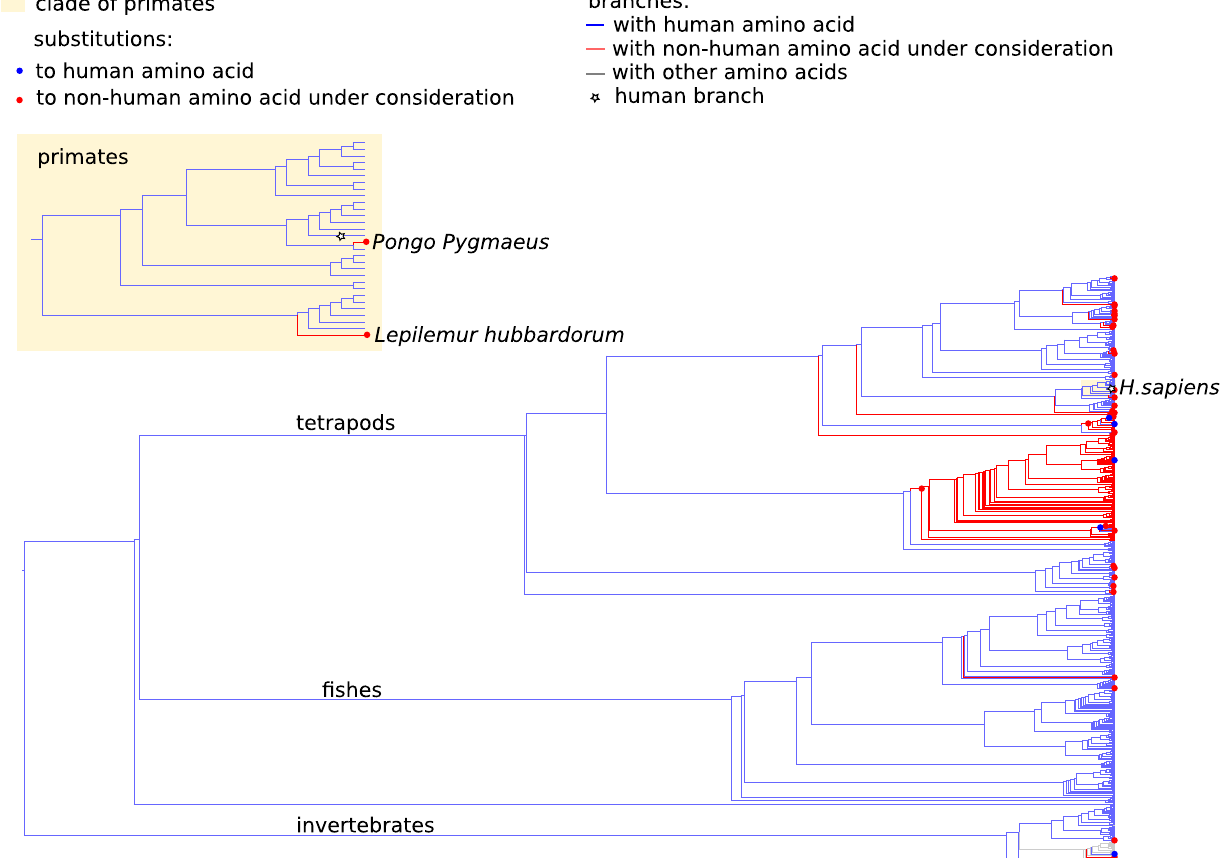
Figure 4. Substitutions to I (human normal variant, blue dot) and V (LHON variant, red dot) in site 58 of ND6 across the dataset and on a clade of Primates (yellow rectangle). Blue and red branches are occupied by I and V, respectively. White star—Homo sapiens